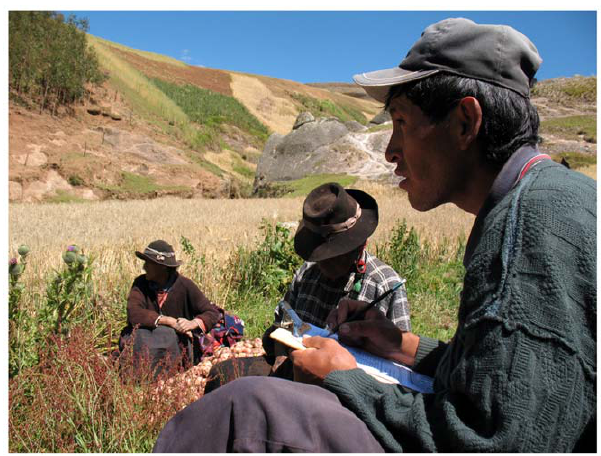
Figure 3. Community knowledge worker assisting farmers with record-keeping activities associated with their potato harvest. The individual pictured in this manuscript has given written informed consent (as outlined in the PLoS consent form) to appear in the